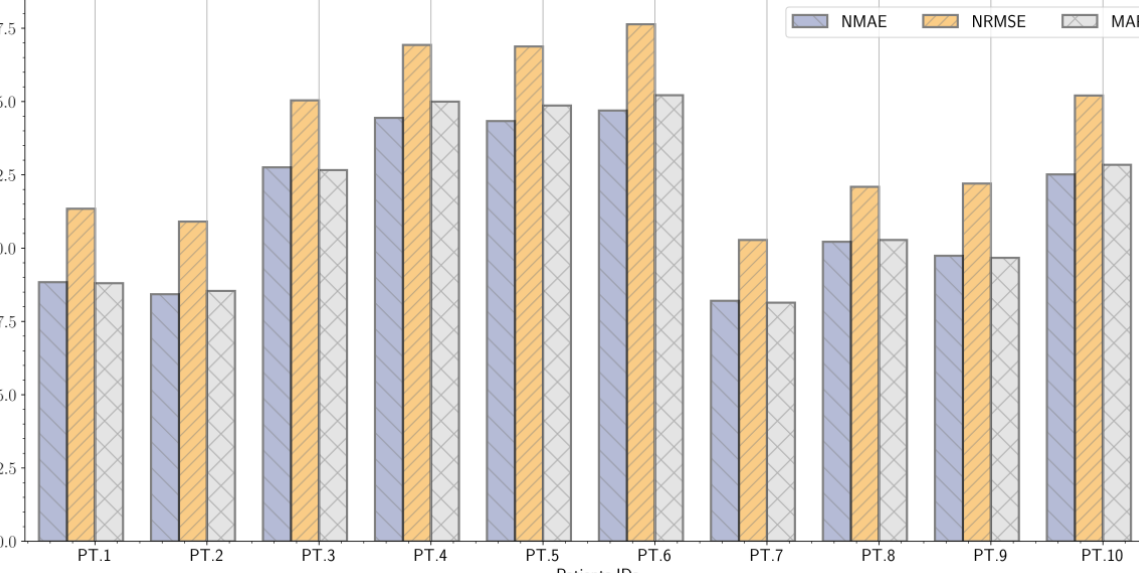
Figure 15. Bar plots of the normalized mean absolute error, normalized root mean square error, and mean absolute percentage error between reference device (thoracic belt) and the microbend fiber optic sensor for respiratory rate estimation. MAPE: mean absolute percentage error; NMAE: normalized mean absolute error; NRMSE: normalized root mean square error; RR: respiratory